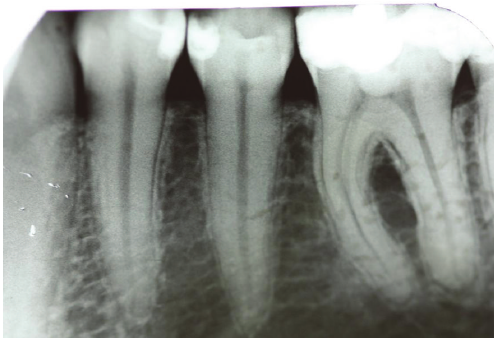
Figure 2: Radiolucency image of tooth 36 showing a periapical radiolucency in the region of the mesial and distal root